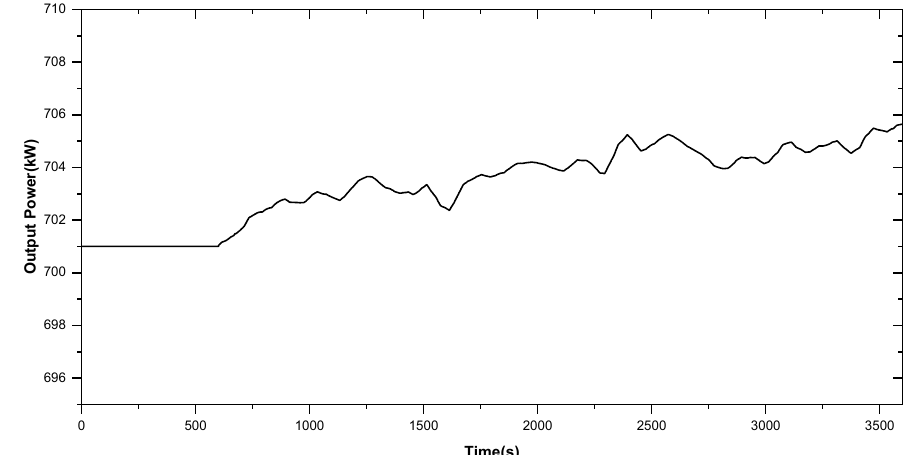
Figure 8. The power curve after FESS compensation.